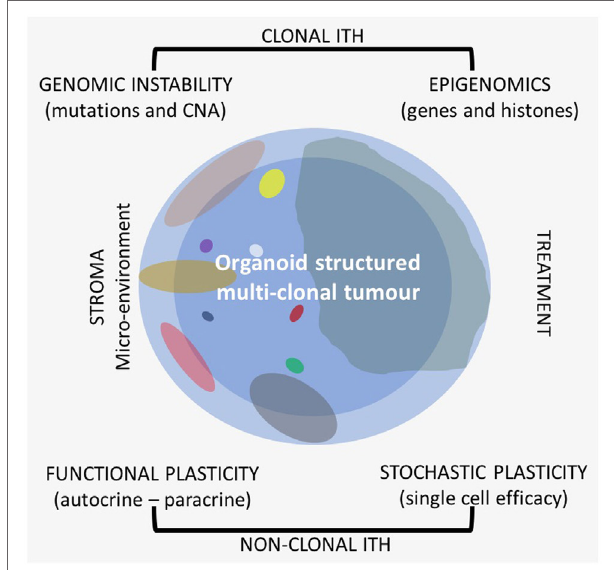
FiGURe 1 | Different types of intra-tumor heterogeneity (ITH) in an organoid structured multiclonal tumor: the primary clone is blue (the peripheral area is light blue and the central one is darker), the other clones are of different size and multicolor.